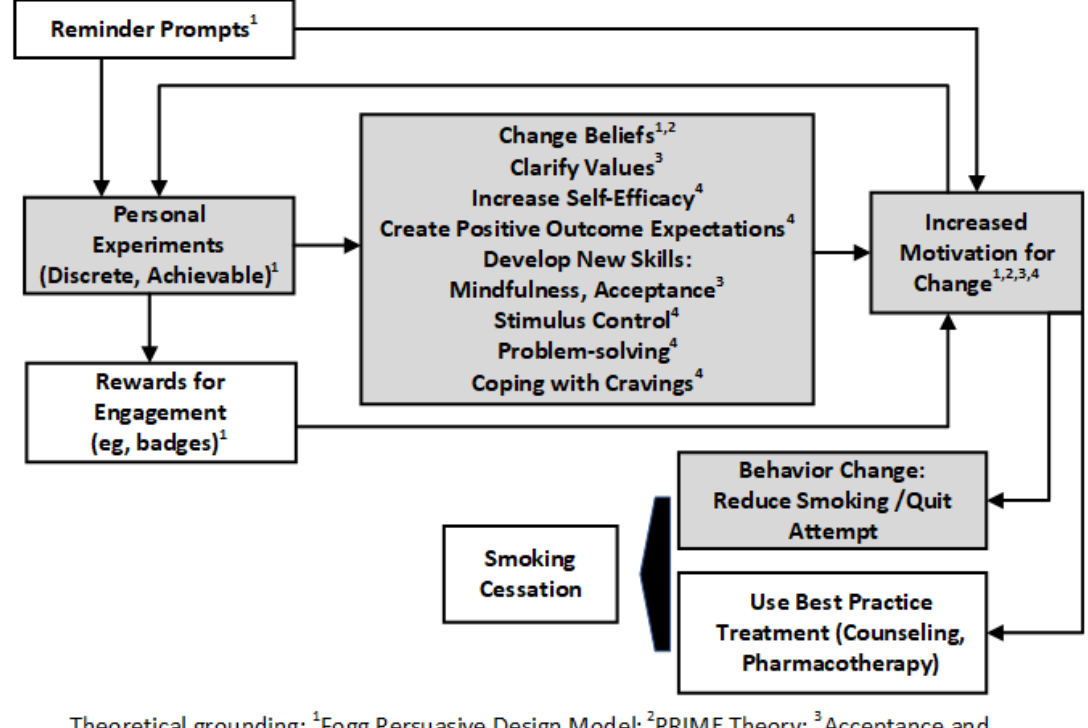
Figure 1. Conceptual model of the